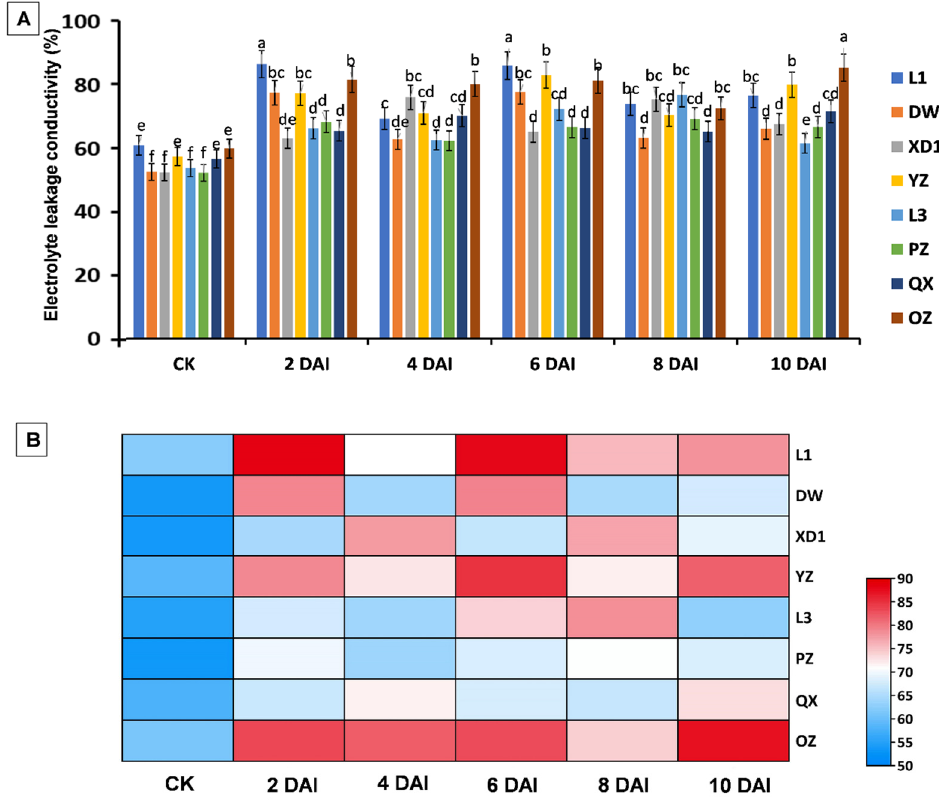
Figure 2. Plasma membrane permeability analysis by electrolyte leakage conductivity in eight hazelnut varieties (Liao 1 (L1), Dawei (DW), Xianda No. 1 (XD1), Yuzhui (YZ), Liao 3 (L3), Ping hazelnut (PZ), Qiuxiang (QX), European hazelnut (OZ)) on 2, 4, 6, 8 and 10 days after inoculation (DAI) of B. cinerea infection. ( A ) The percentage electrolyte leakage conductivity. ( B ) Clustered heat map showing the intensity of electrolyte leakage from lower (blue color) to higher (red color) in eight hazelnut varieties post B. cinerea infection. Different letters above bars indicate significant difference at p ≤ 0.05.